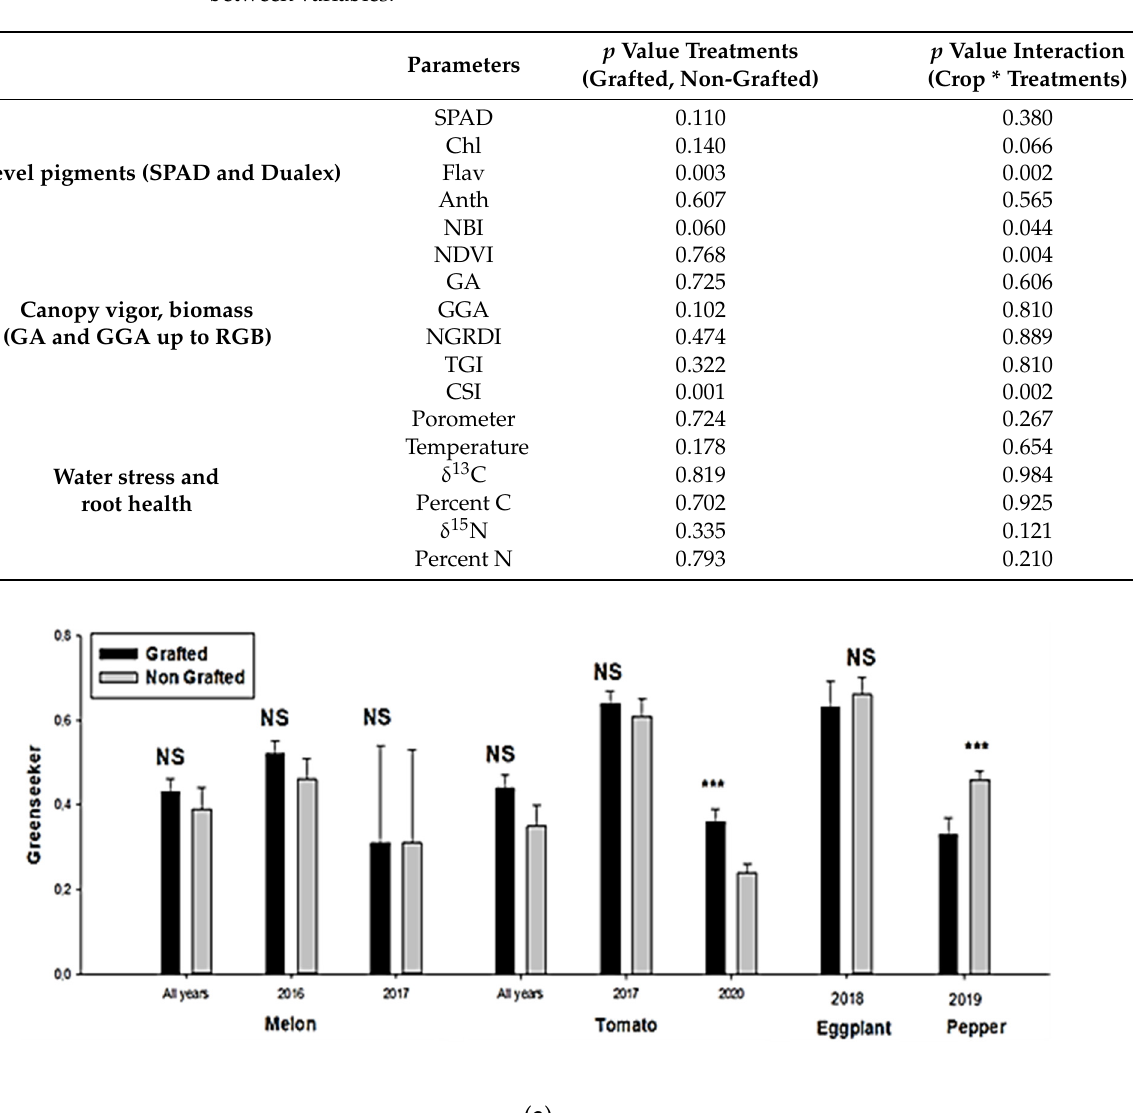
Table 4. ANOVA of three classes of parameters (leaf level pigments, canopy vigor and biomass, water stress and root health) achieved for four crops (melon, tomato, eggplant, pepper) with two treatments (grafted, non-grafted) n = 152 for an experience during five years (2016–2020) under greenhouse in soil infected by root-knot nematode in order to show the role of grafting in the protection of plant and reduce the effect of this pest. We also show the effect separately of crop, treatments, and the interaction of both. SPAD (Soil Plant Analysis Development), Chl (chlorophyll), Flav (flavonoid), Anth (anthocyanin), NBI (Nitrogen Balance Index), GA (Green area), GGA (Greener Green Area), TGI (Triangular Greenness Index), NGRDI (Normalized Green Red Difference Index), CSI (Crop Senescence Index), δ 13 C (isotopic composition of carbon 13), percent C (percentage of carbon), δ 15 N (isotopic composition of nitrogen 15), and percent N (percentage of nitrogen), *: Interaction between